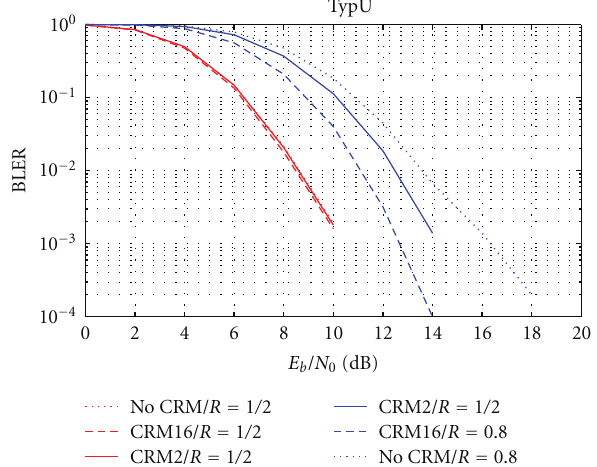
Figure 8: BER performance of an SISO LDPC transmission with CRM, TypU channel.